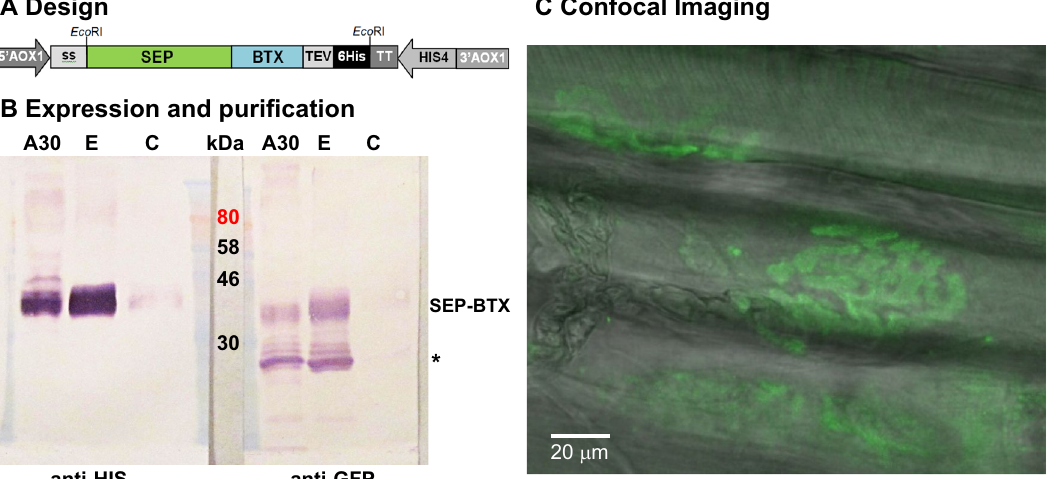
Figure 1. A Construction design for the expression of SEP-BTX in P. pastoris . The DNA coding sequence for the SEP-BTX fusion protein was inserted into the Eco RI site of the expression vector pPIC9. It was cloned downstream and in frame with the alpha factor signal sequence (ss) of S. cerevisiae and upstream of the coding sequences for the recognition peptide for tobacco etch virus protease (TEV) and a 6 × His tag (6His). 5 ′ AOX1, TT and 3 ′ AOX1: promoter region, transcription terminator and 3 ′ region of P. pastoris alcohol Oxidase 1 gene, respectively. HIS4: Histidinol dehydrogenase gene for selection of transformants in minimal medium. B Western blot of recombinant SEP-BTX purification fractions revealed with anti-His tag (left) or anti-GFP (right) antibodies. Culture supernatant (C) was concentrated by ultrafiltration with a 30 kDa Amicon Ultra (A30) and SEP-BTX was purified and eluted (E) by gravity flow Ni–NTA affinity chromatography. Marker: Colorplus Prestained Protein Marker (New England Biolabs). The expected molecular weight of the fusion protein is around 37 kDa. A smaller fragment was also detected by the anti-GFP antibody (*). The presence of this fragment did not prevent proper binding of SEP-BTX to the acetylcholine receptor. C Confocal image of a levator auris NMJ junction incubated with the SEP-BTX fusion protein and captured with Nomarsky optics (488 nM wavelength light excitation, 510 nM emission). Fluorescence and transmission images were